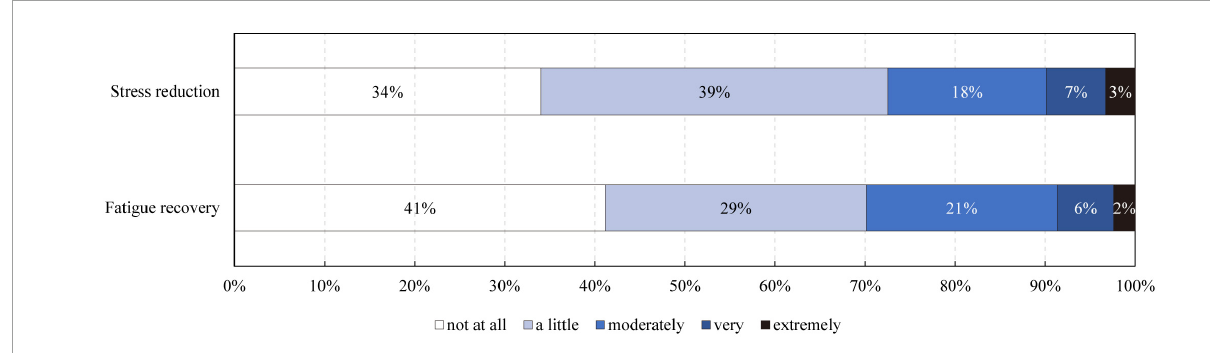
FIGURE4 The percentage of children that need stress reduction and fatigue recovery.